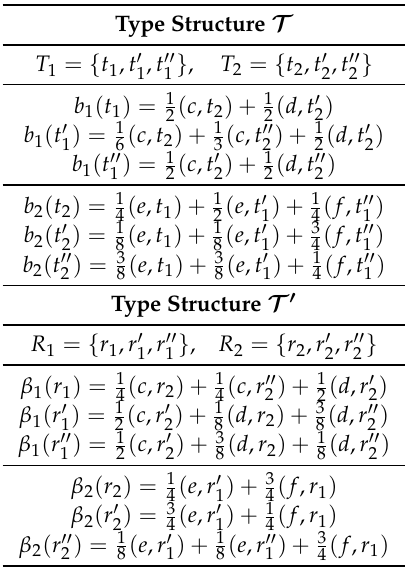
Table 1. Two equivalent type